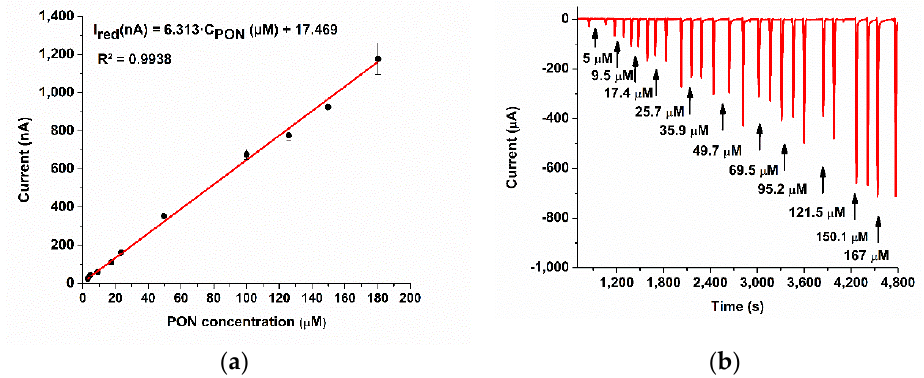
Figure 9. ( a ) Calibration curve of the SPCE/CoPc electrode for PON, PBS pH 9. ( b ) Chronoamperogram measured using the FIA system and the SPCE/CoPc electrode, E = 0.1 V, flow rate = 0.4 mL/min [1]. By replacing the electrochemical polarization of the SPCE/CoPc electrode during the 60 s, at − 0.3 V with the chemical oxidation of the CoPc film using sodium borohidrate (25 mM), for 20 min, the calibration was improved to Ired (nA) = 10.843 · C PON ( µ M) − 36.484 (R 2 = 0.9925). The new LOD was equal to 0.42 µ M, and the LOQ was 1.4 µ